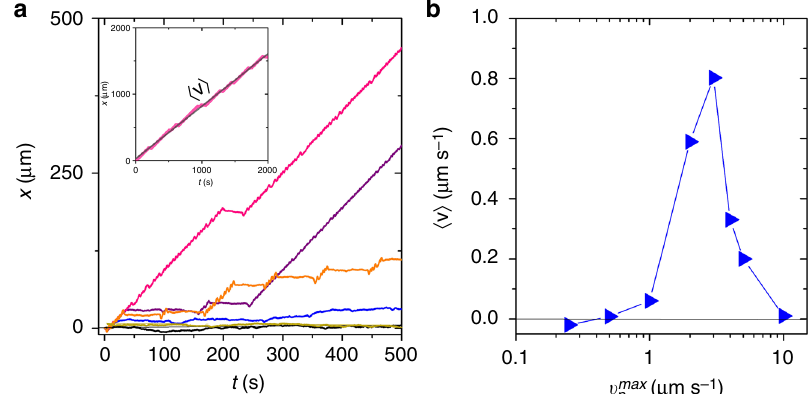
Fig. 6 Transport of APs with different velocities by periodic trains of traveling pulses. a Numerical trajectories for APs with different propulsion velocities = 0.5 μ m/s (black), v max = 1.0 μ m/s (blue), v max = 2 μ m/s (purple), v max = 3 interacting with a train of pulses for u = 1 μ m/s, w = 4 σ , and T = 50 s ( v max p p p p μ m/s (pink), v max = 5 μ m/s (orange), v max = 10 μ m/s (yellow)). (Inset) Long-time particle trajectory ( v max = 3 μ m/s) with the solid line corresponding to a p p p linear fi t with slope 〈 V 〉 . b Corresponding 〈 V 〉 vs. v max p